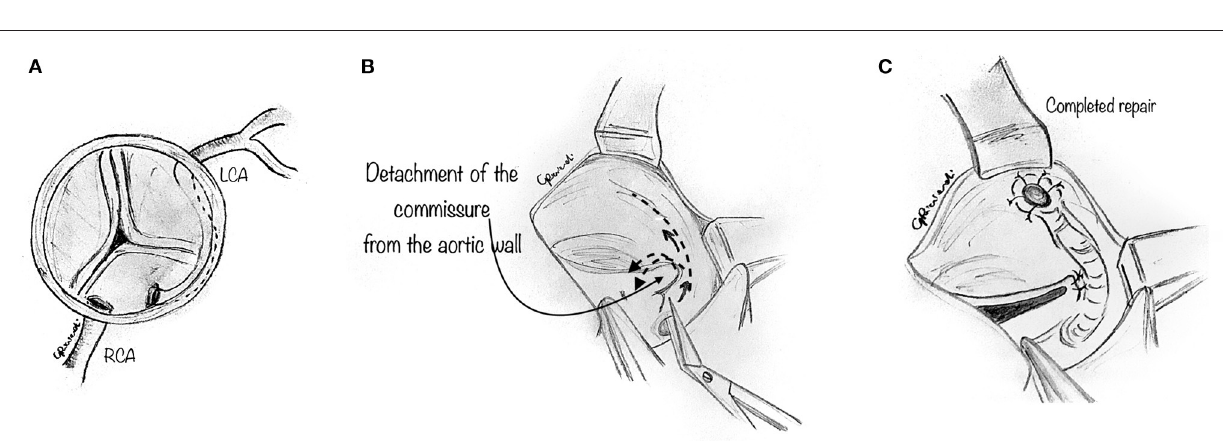
FIGURE 3 | Unroofing technique. (A) The orifice of the anomalous coronary artery origin is gently explored with a coronary probe to determine the extent of any intramural segment and its relationship to the correct sinus. (B) Diagram showing a small right-angle clamp which is gently placed into the anomalously located coronary ostium to determine its intramural course and evaluate the overlying common wall of the coronary artery and aorta. (C) Diagram showing a small right-angle clamp inserted into the anomalously located coronary ostium, and gently pushed inside the intramural course, to reveal the overlying common wall of the coronary artery and aorta which is incised with a blade and unroofed.